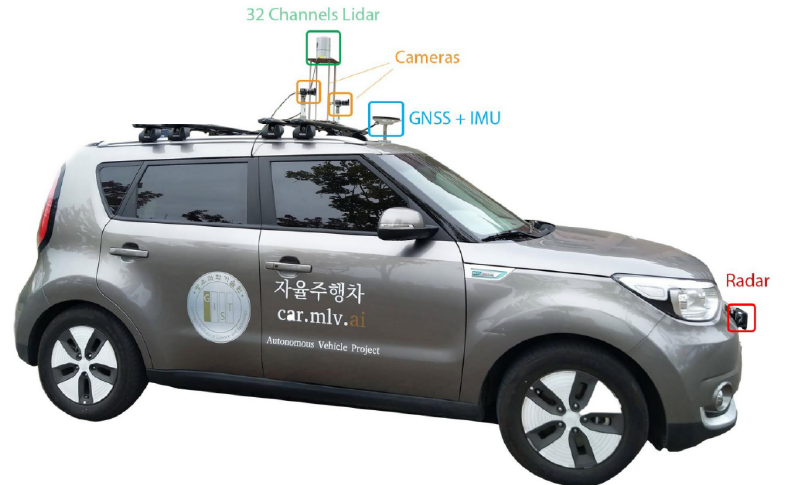
Figure 1. Our KIA-Soul EV is equipped with two FLIR cameras, a 3D 32-laser scanner and a GPS/IMU inertial navigation system [24] (Best viewed in